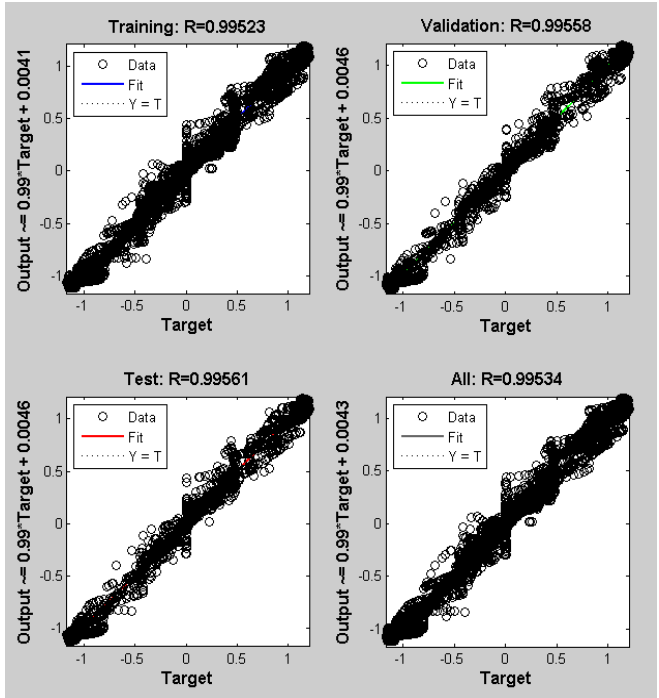
Figure 11. Regression plot of Artificial Neural Network (ANN).